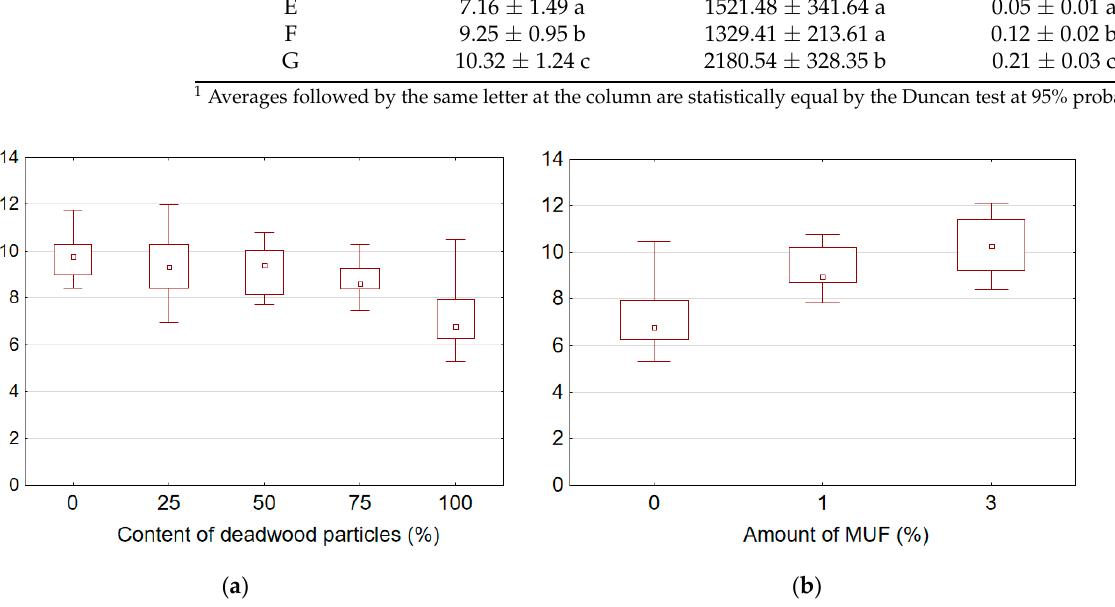
Figure 6. Bending strength of boards samples depending on content of deadwood particles ( a ) and amount of MUF resin in adhesive ( b ).